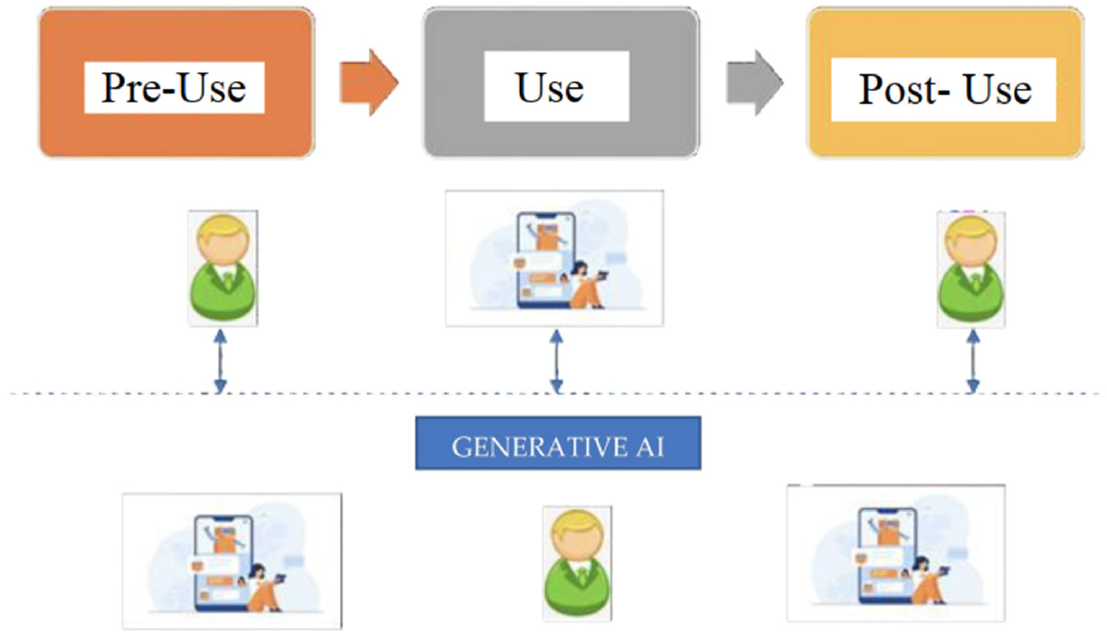
Figure 2. Customer experience and co-creation process with GAI. Source: authors’ conception.